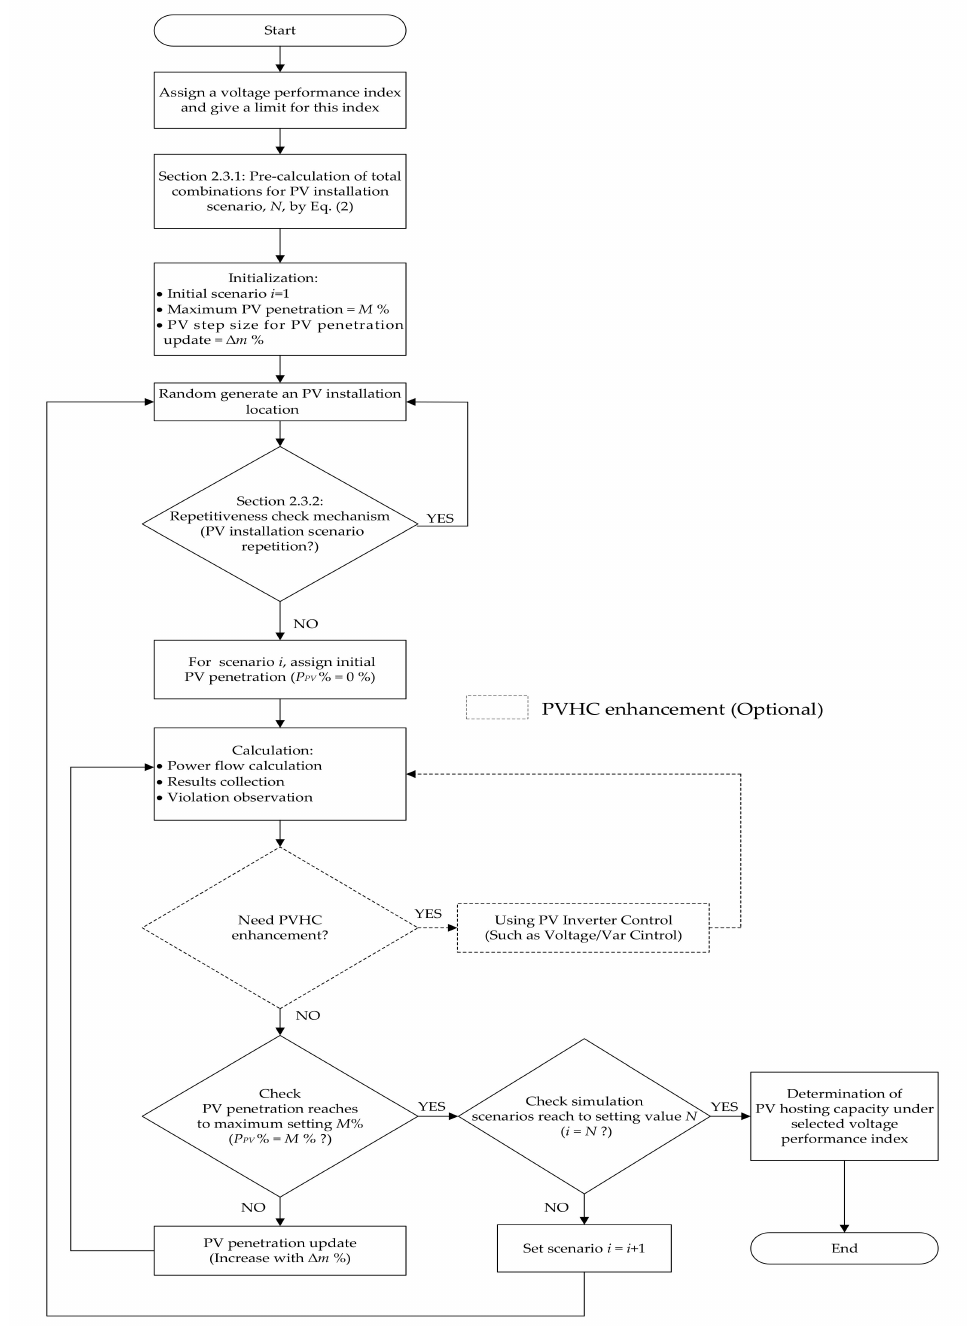
Figure 3. Flowchart of the proposed stochastic analysis method